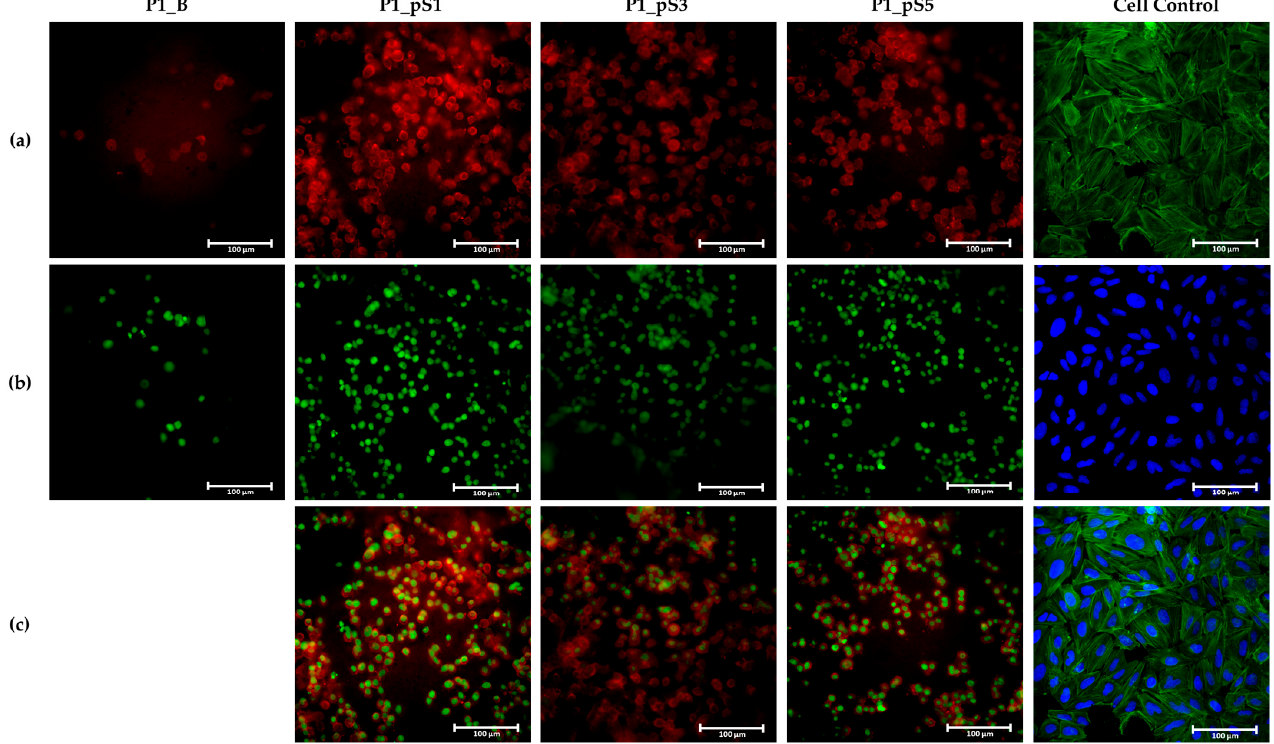
Figure 10. Fluorescence of Saos-2 cells on scaffolds without pSPIONs (P1_B), containing 1.92 wt.% of pSPIONs (P1_pS1), containing 3.77 wt.% of pSPIONs (P1_pS3), and containing 5.54 wt.% of pSPIONs (P1_pS5) using Phalloidin CruzFluor™ 488 Conjugate, Helix NP Green and DAPI where: ( a ) Cytoskeleton of the cells on top of the scaffolds (red) and cytoskeleton of the cell control (green); ( b ) Nucleus of the cell on top of the scaffolds (green) and nucleus of the cell control (blue); and ( c ) Merge of the images obtained for the cytoskeleton and nucleus. Scale size: 100 µm.